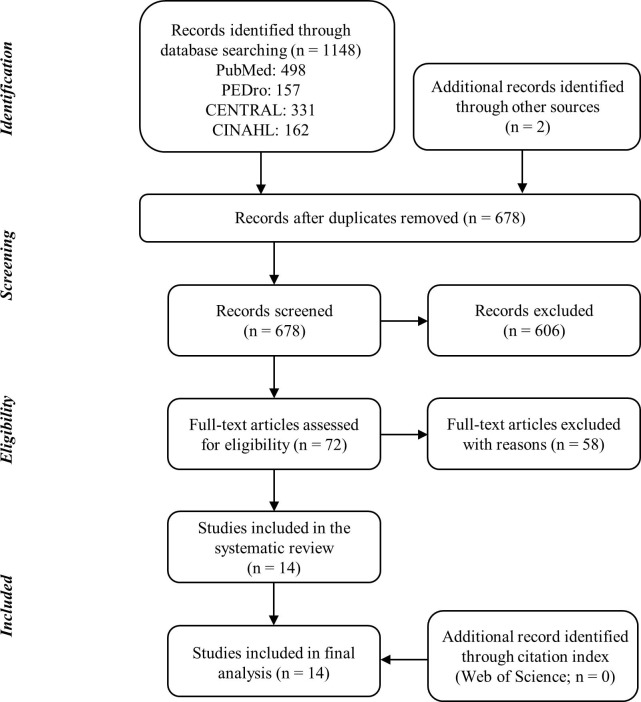
Review flow diagram.